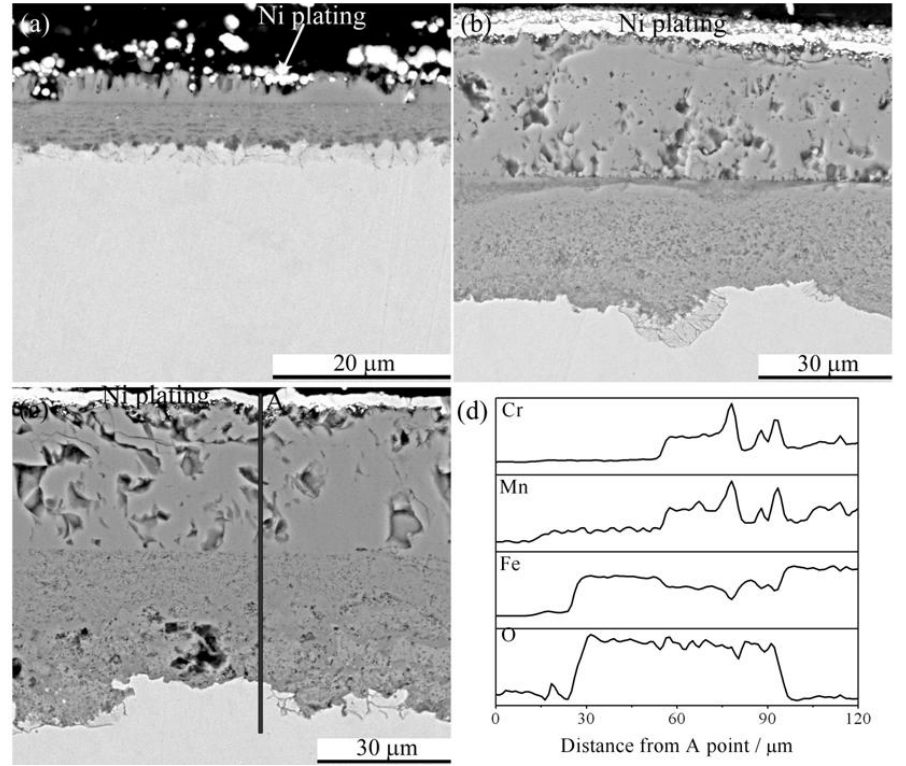
Figure 8. Cross section morphologies of base oxide scales formed on P92 after 24 h oxidation in pure steam at ( a ) 600 °C; ( b ) 700 °C; and ( c ) 800 °C; and ( d ) chemical composition distribution along the line indicated in ( c ).